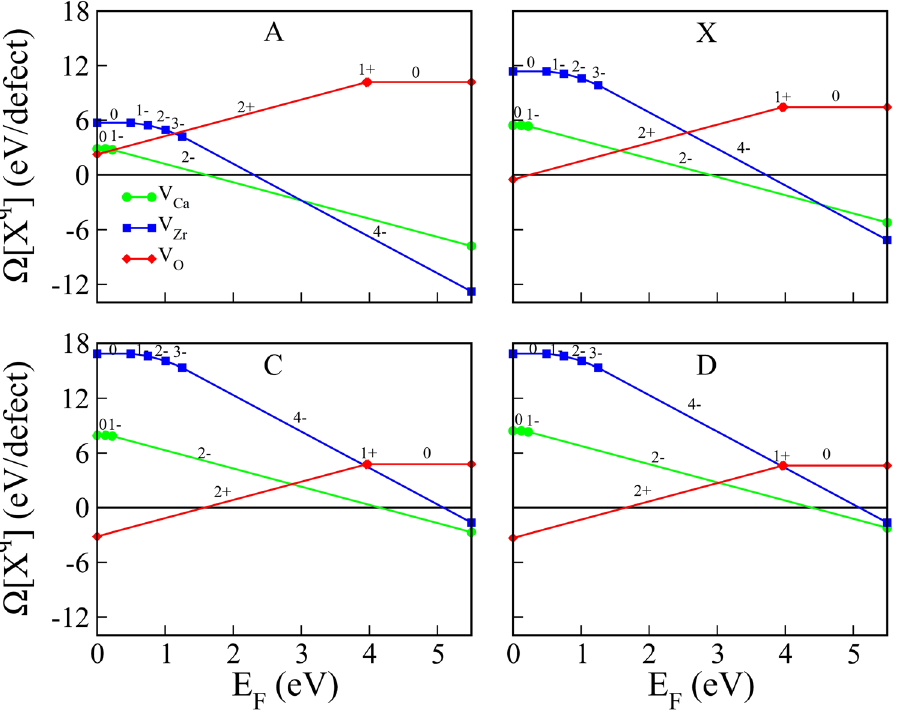
Figure 7. The variation of the Ω X [ ] q with E F for selected stability points. Signed numbers over the lines indicate the charge states of the vacancy defect.